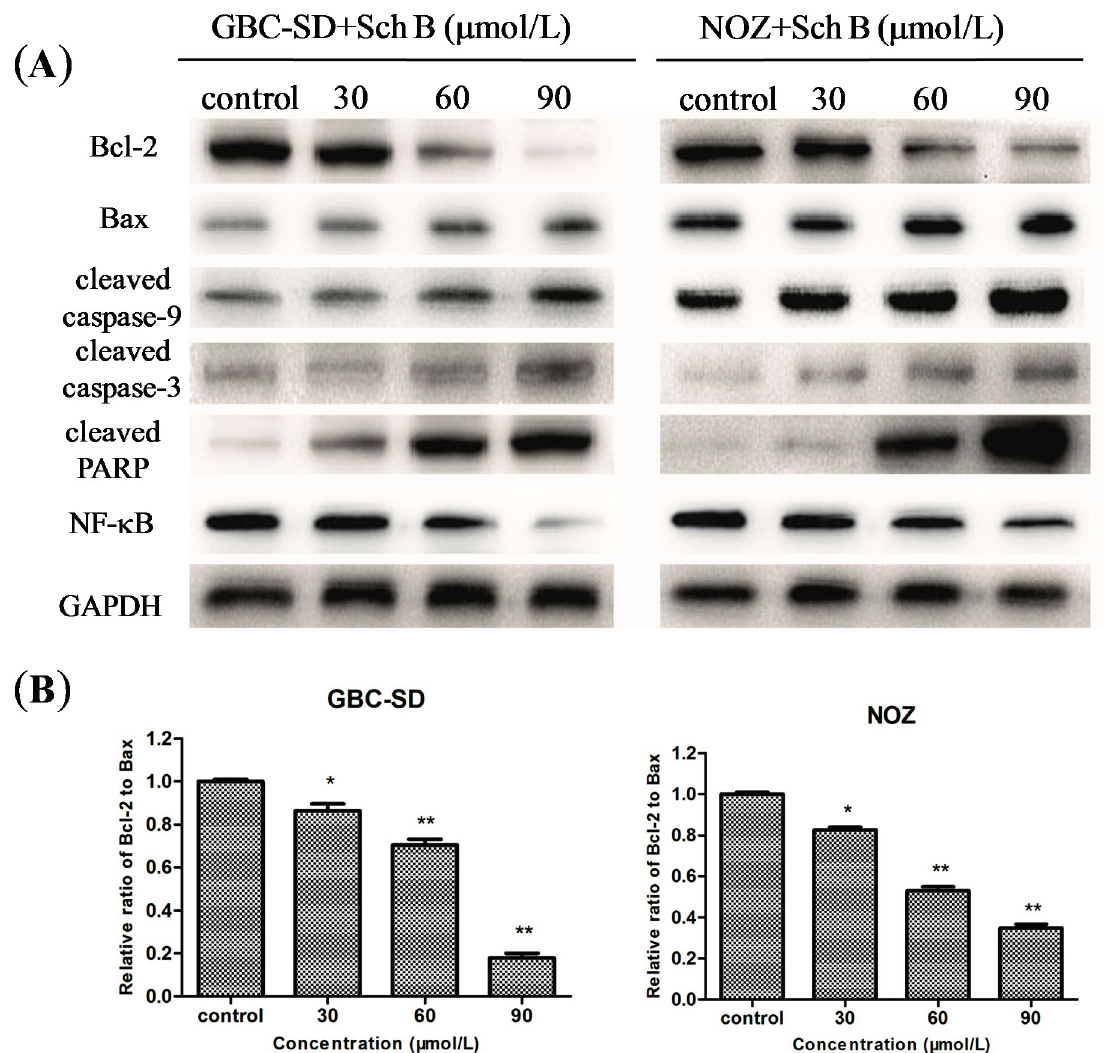
Figure 5. Sch B-induced apoptosis via regulation of Caspase and Bcl-2 family members in gallbladder cancer cells. ( A ) GBC-SD and NOZ cells were treated with Sch B (0, 30, 60, and 90 μ mol/L) for 48 h. The expression levels of Bcl-2, Bax, cleaved caspase-9, cleaved caspase-3, cleaved PARP and NF- κ B were detected by western blot analysis, and GAPDH was used as a loading control; ( B ) The data of the relative ratio of Bcl-2 to Bax (mean ± SD); The results shown were representative data from 3 independent experiments. * P < 0.05, ** P < 0.01 vs. the control